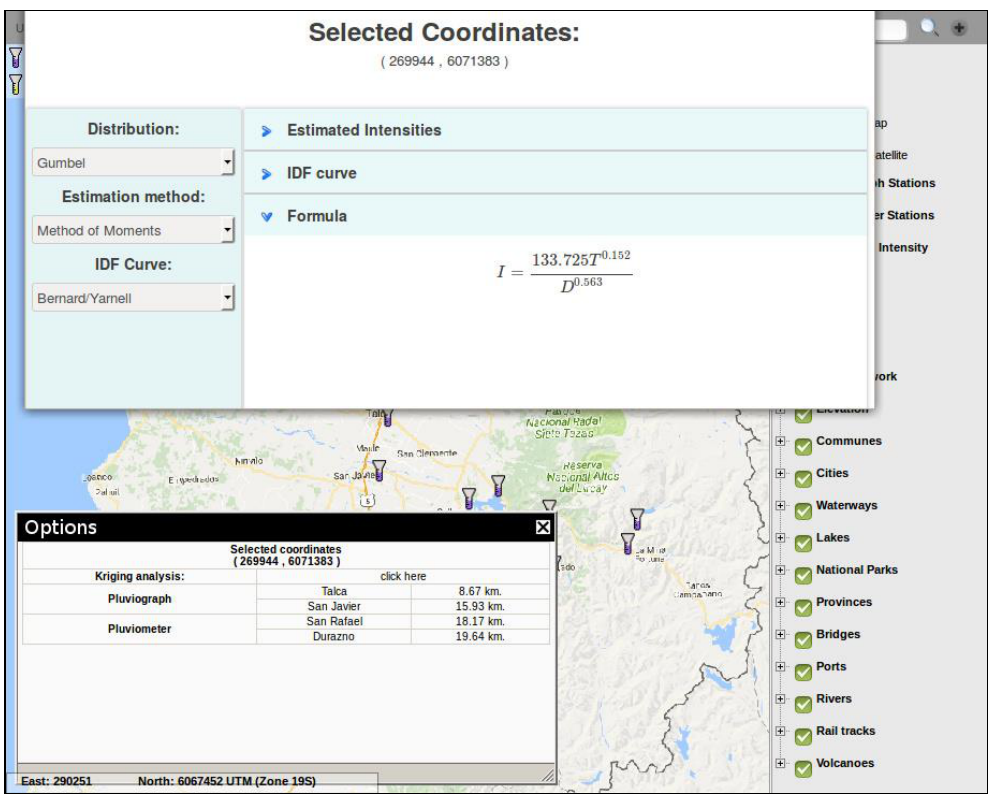
Figure 11. Geostatistical interpolation of IDF Curves in WEBSE IDF using ordinary Kriging method at a selected location.